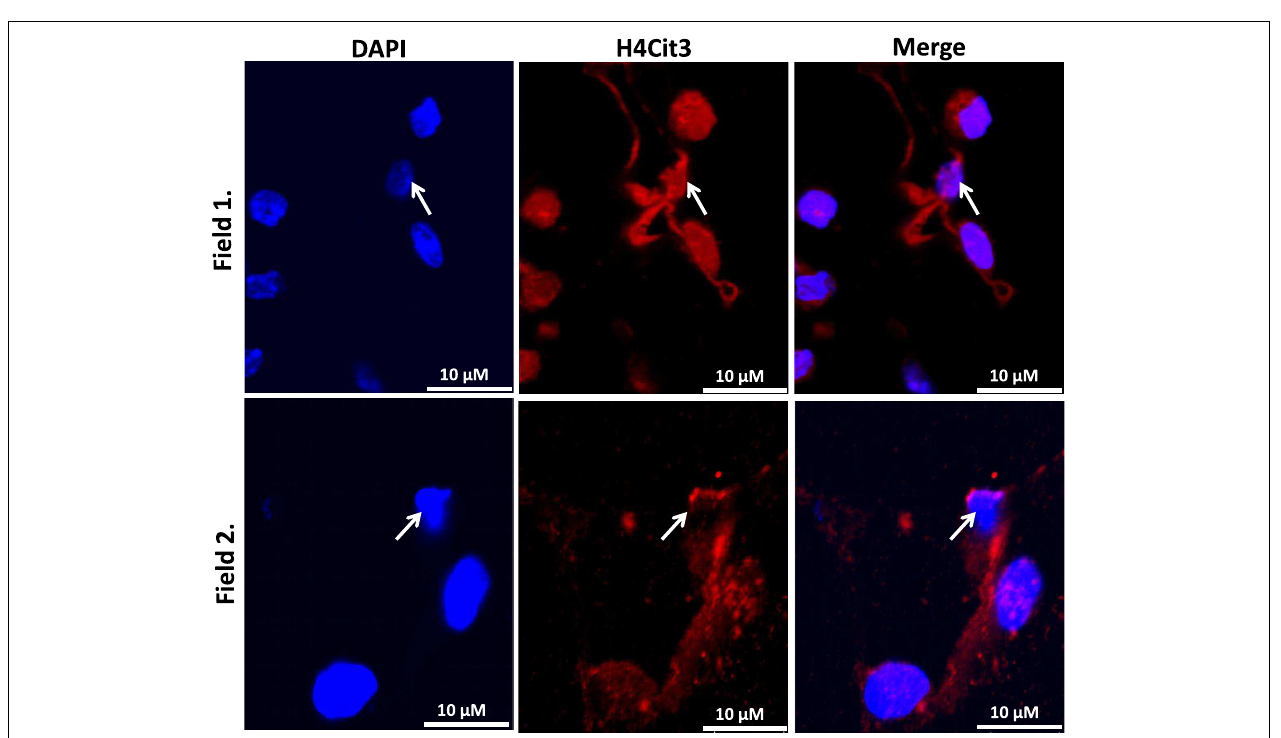
the anti-H4Cit3 antibody shows that extranuclear citrullinated histones appear to extend into the extracellular space between cells within CLS lesions. Arrow highlights nuclei from which the extracellular histones appear to originate.